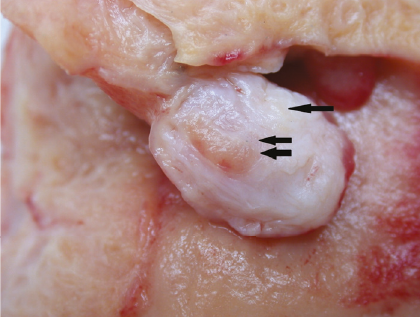
Figure 1: Macroscopically, this polyp appeared white, fibrous, fasciculate (glandular component, double arrow), and focally yellow (one arrow).